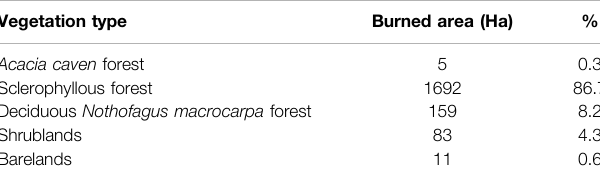
TABLE 1 | Burned area according the forest cadaster (CONAF,